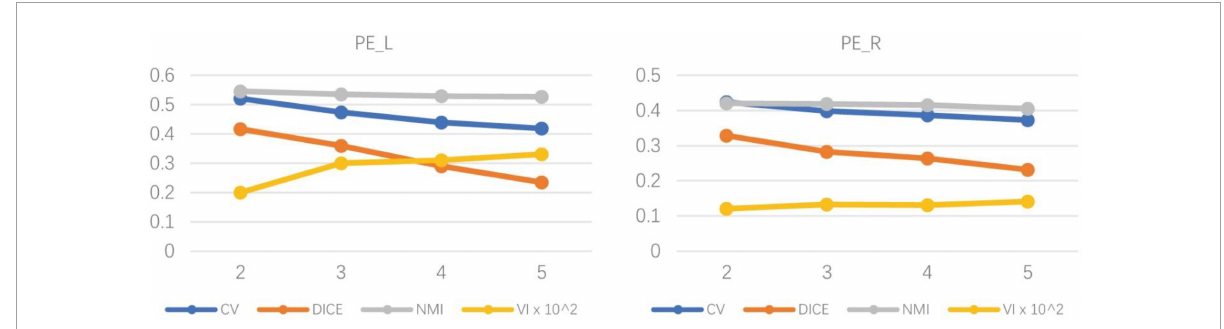
FIGURE4 The trend chart of indexes of the left and right hemispheres under different subdivision scheme results. The trend graph on the left shows the evaluation indexes of the four segmentation results of the left hemisphere of the brain, and the trend graph on the right shows the evaluation indexes of the four segmentation results of the right hemisphere of the brain. With the increase in the number of partitions, the evaluation indicators under different partition schemes all decrease to varying